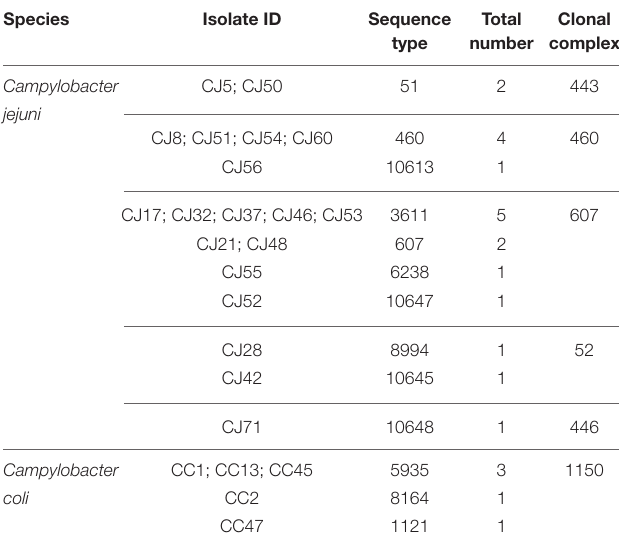
TABLE 3 | Distribution of sequence types and clonal complexes among Campylobacter strains from chicken ( n = 24). Species Isolate ID Sequence